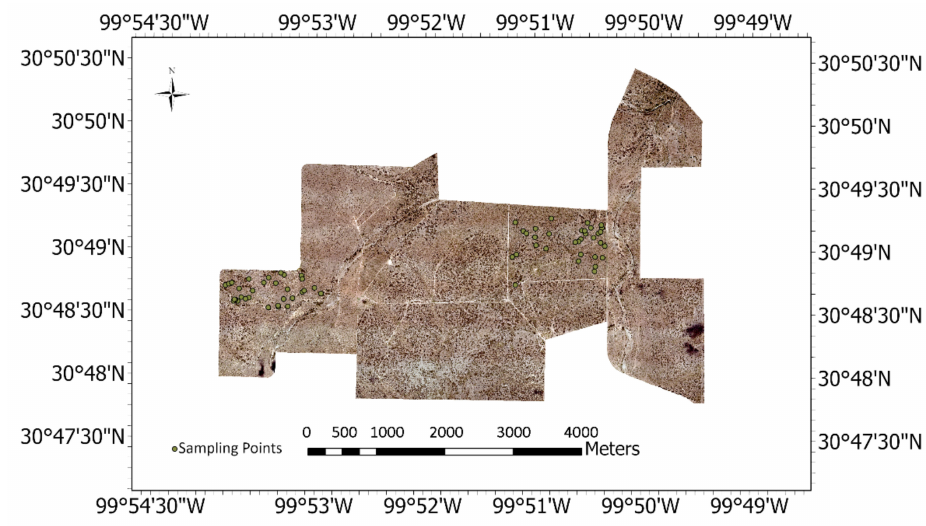
Figure 1. Study area and field sampling